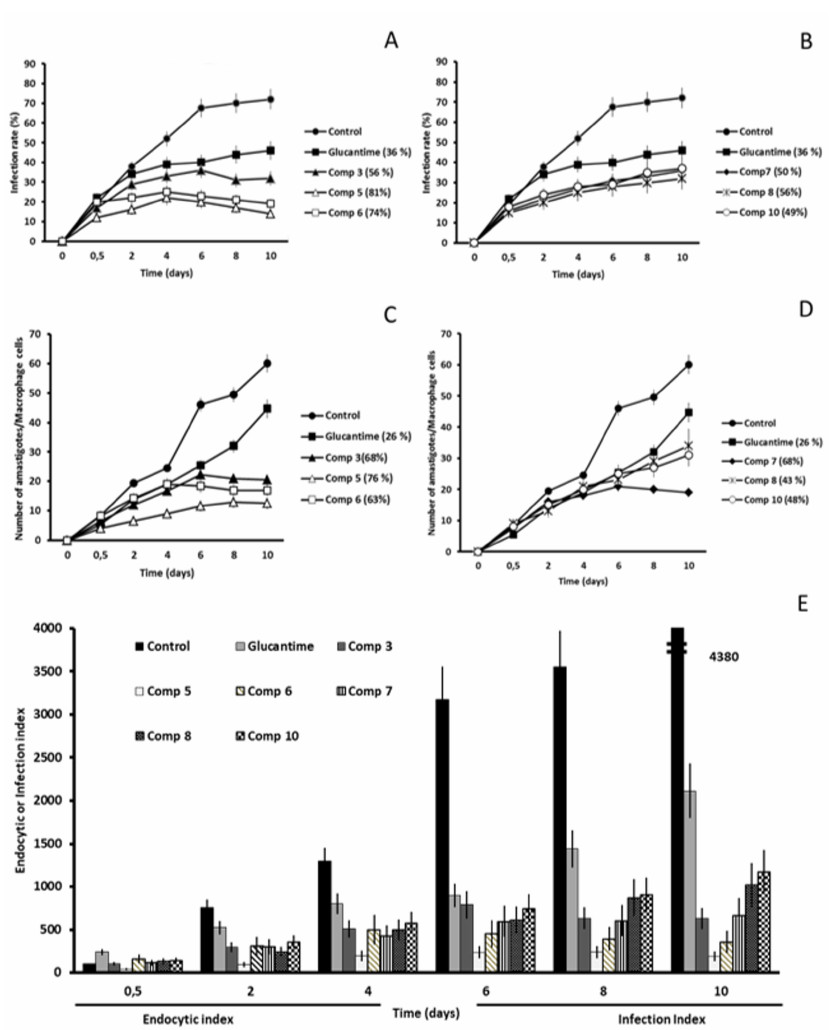
Figure 2. Leishmania braziliensis infectivity assay. ( A , B ) Infection rate percentage and ( C , D ) amastigote count per macrophage cell. In brackets: percentage of decrease in infection rate/number of amastigotes per macrophage cell in comparison to the control measured on the last day of the experiment (peak of infection). ( E ) Effects of the compounds on the endocytic and infection indexes. Each drug at IC 25 concentration was tested in triplicate. Values are the means of four separate determinations ± standard